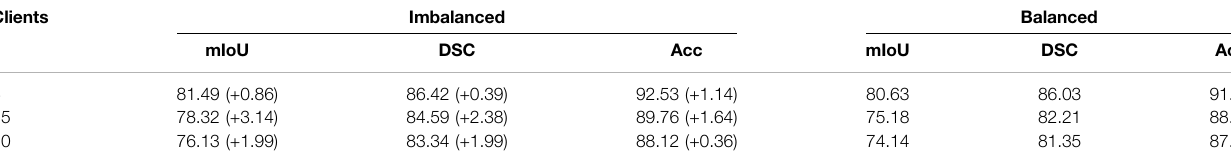
TABLE 3 | Performance of imbalanced and balanced distribution on different clients ’ number at epoch = 100.